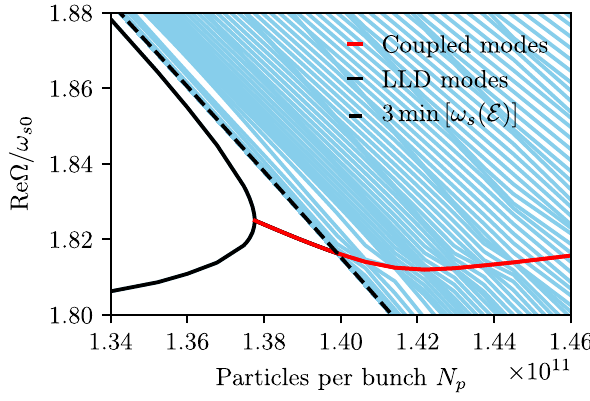
FIG. 11. Power spectra of quadrupole (blue) and sextupole (orange) azimuthal modes of the LLD type. The dashed line corresponds to the zeroth radial mode of the quadrupole azimu- thal mode evaluated using Eqs. (23) and